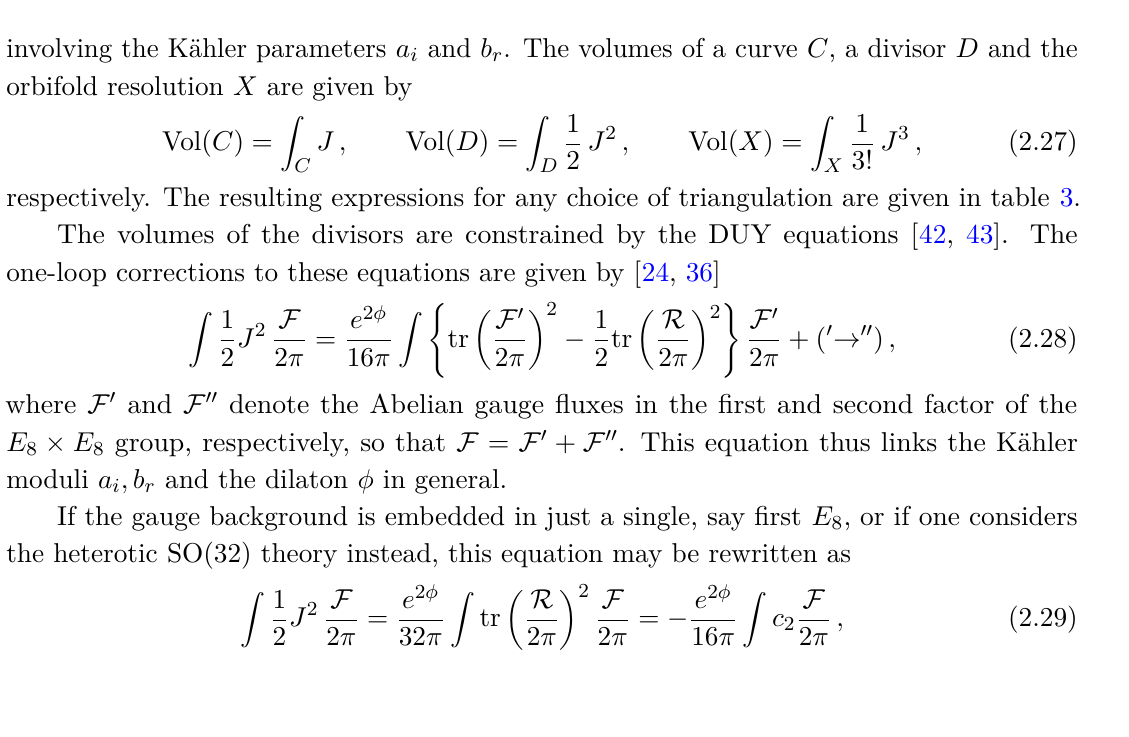
Table 3 . Volume of a collection of possibly existing curves, divisors and the resolved orbifold X as a whole using arbitrary triangulation at the 64 C 3 / Z 2 × Z 2 resolutions. Similar expression of the other curves and divisors can be obtained by